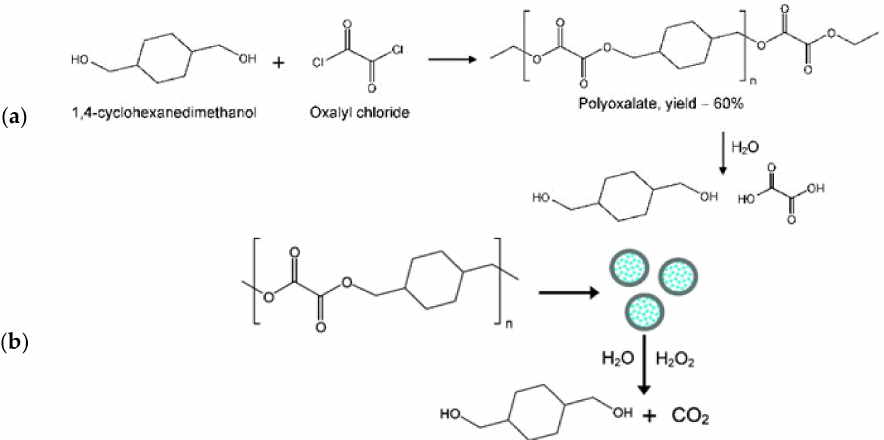
Figure 4. ( a ) Polyoxalate polymer synthesis and degradation, ( b ) nanoformulation preparation and their biodegradation [27] Reprinted with